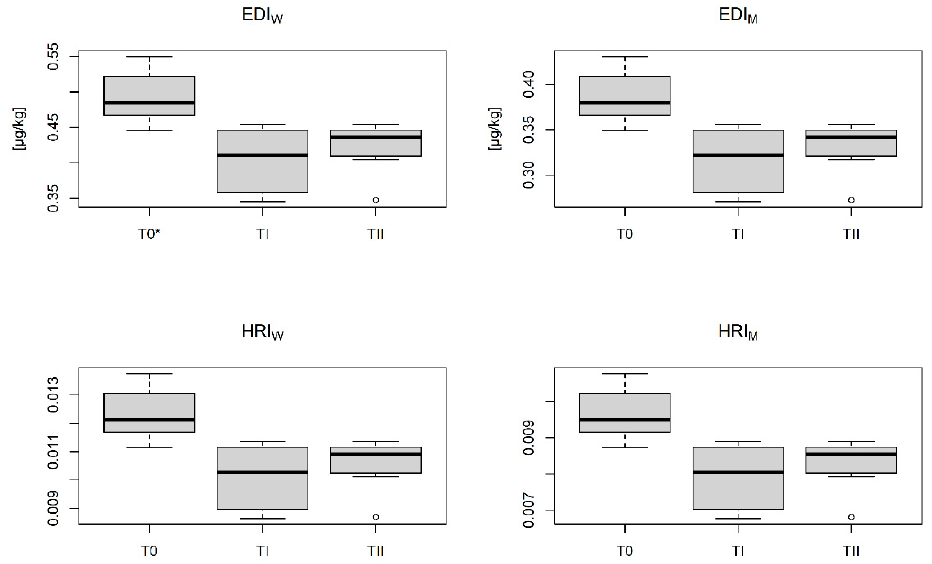
Figure 9. Estimated daily intake (EDI) and health risk index (HRI) calculated for women (W) and men (M) for Cu in oat; * for descriptions see Material and Methods. Statistically significant differences and p -value are presented in Table 3.